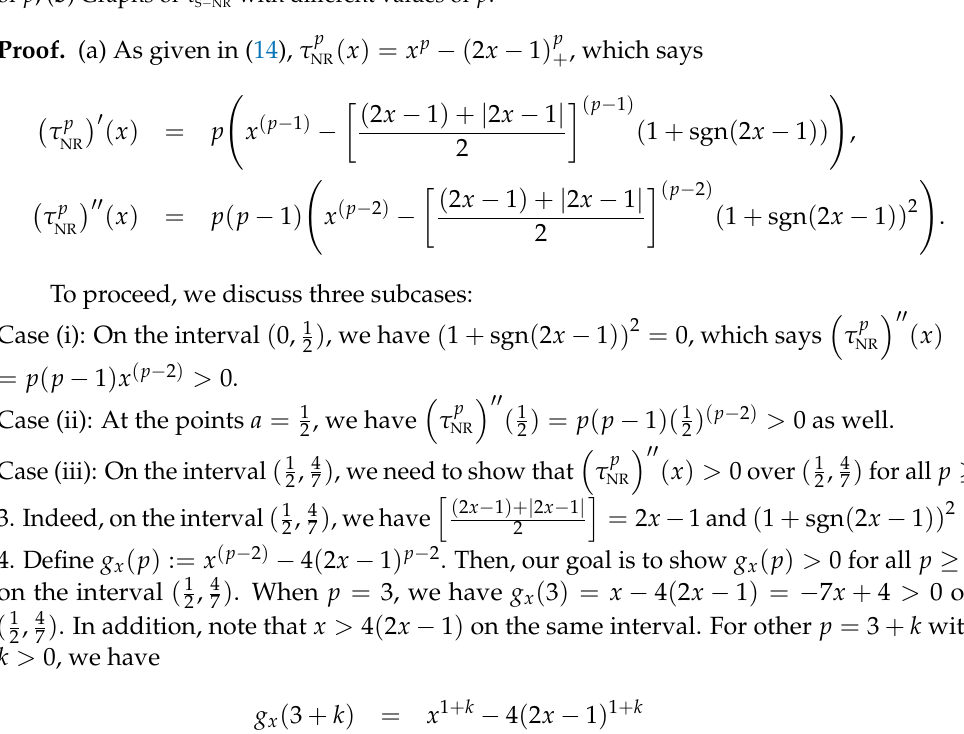
Figure 4. Graphs of τ p of p ; ( b ) Graphs of τ p